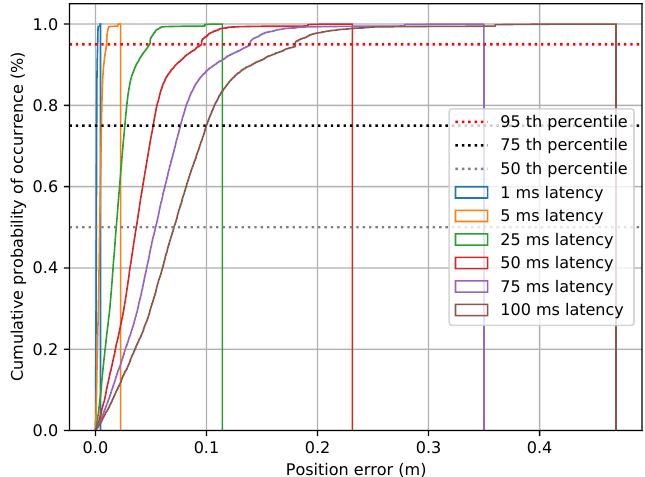
Figure 2. Cumulative distribution function of the positioning error added by the latency in a highway